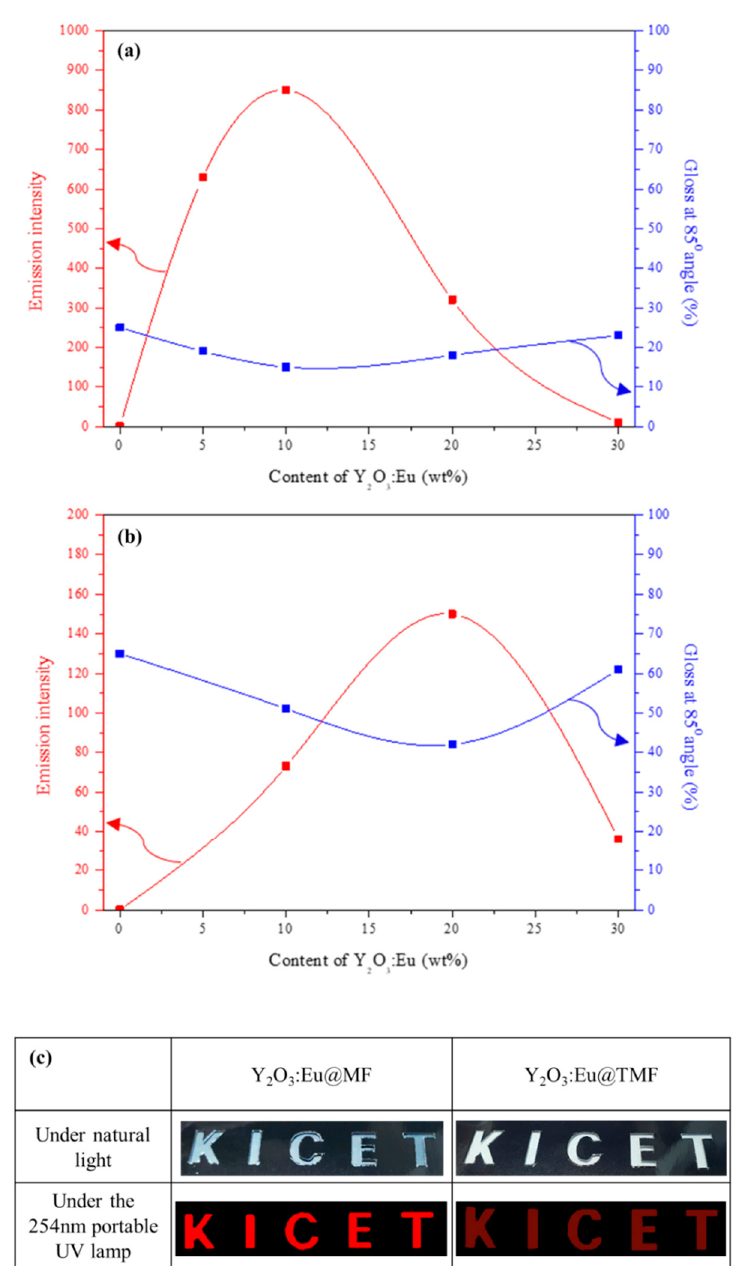
Figure 13. Graph of relationship between gloss at 85 o angle and luminescent property of ( a ) Y 2 O 3 :Eu@MF and ( b ) Y 2 O 3 :Eu@TMF, and ( c ) optical image of the “KICET” mark prepared